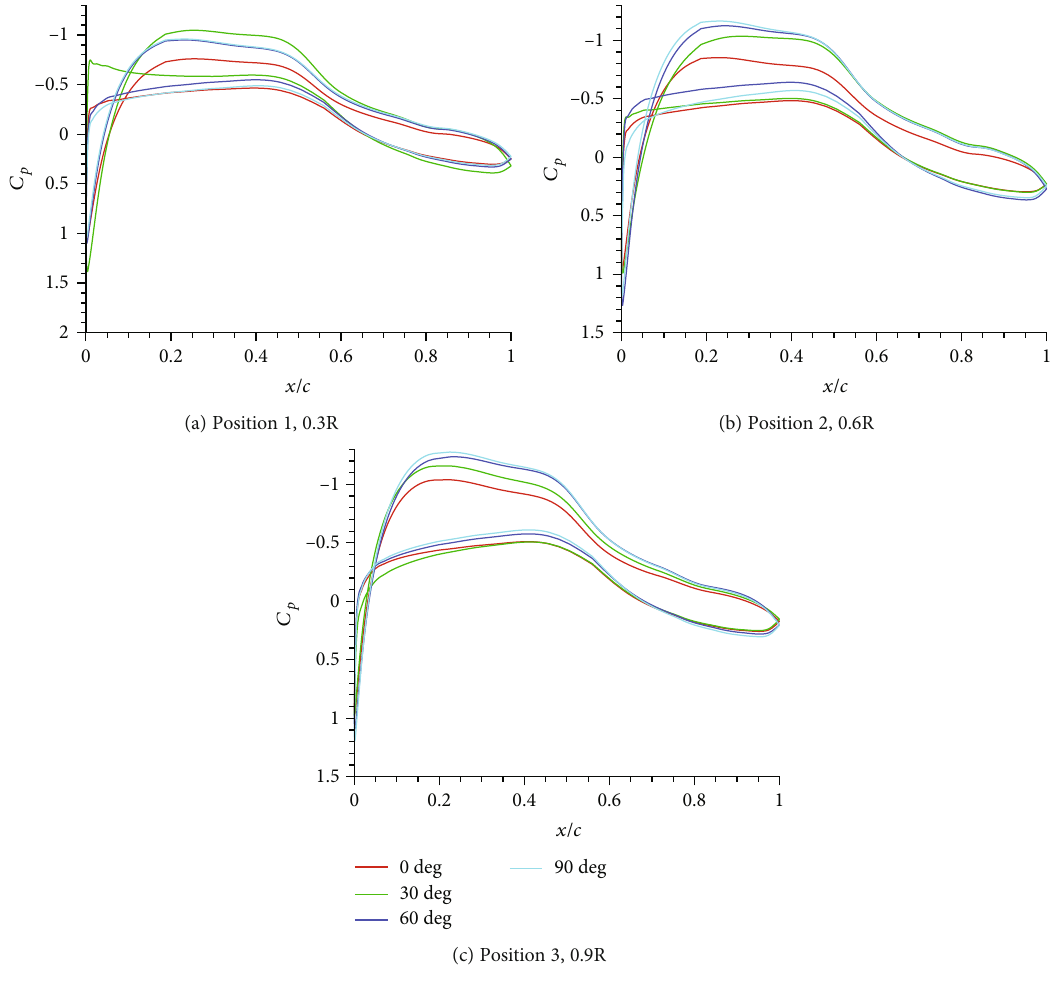
Figure 26: Pressure distributions on wing locations at di ff erent tilt angles.